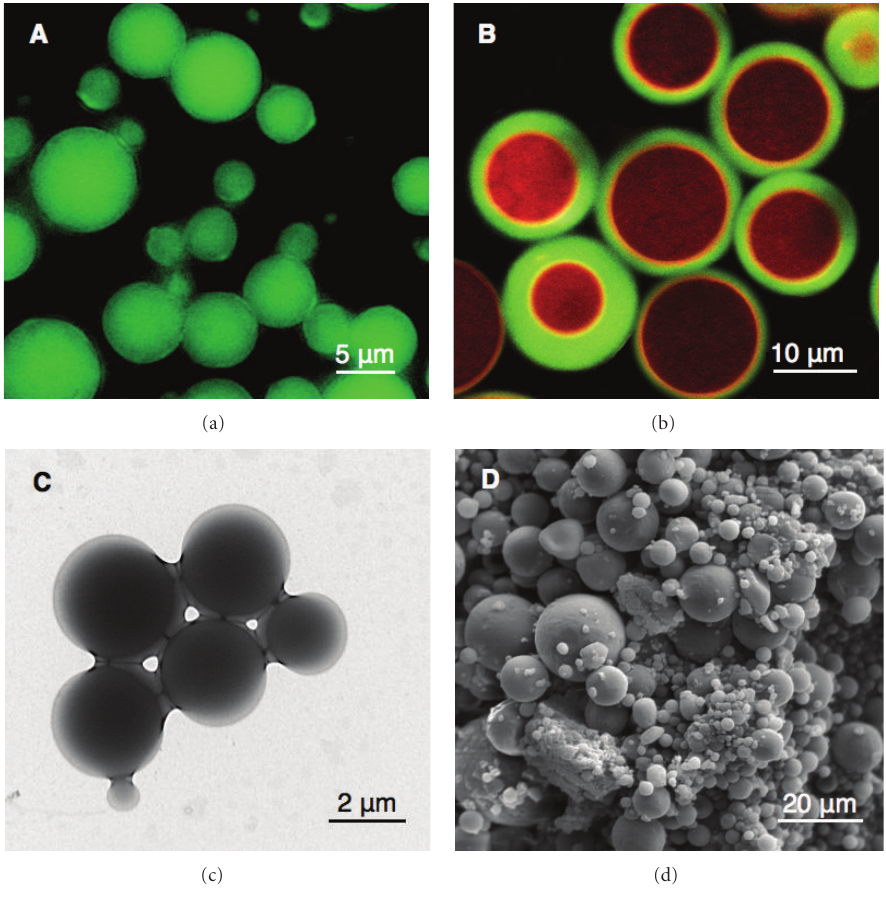
Figure 3: Polymeric microparticles formulated by single- (a) and double- (b, c, and d) emulsion method. Images obtained through confocal laser scanning microscopy of (a) FITC-loaded poly(lactide-co-glycolide) (PLGA) microparticles (MPs) (green), (b) NBD-cholesterol (green), and Texas-Red (red) loaded PLGA microparticles. (c) Transmission electron microscopy (TEM) of ceftiofur-loaded poly(3-hydroxybutyrate- co-3-hydroxyvalerate) (PHBV) microparticles; (d) scanning electron microscopy (SEM) of florfenicol-loaded PHBV